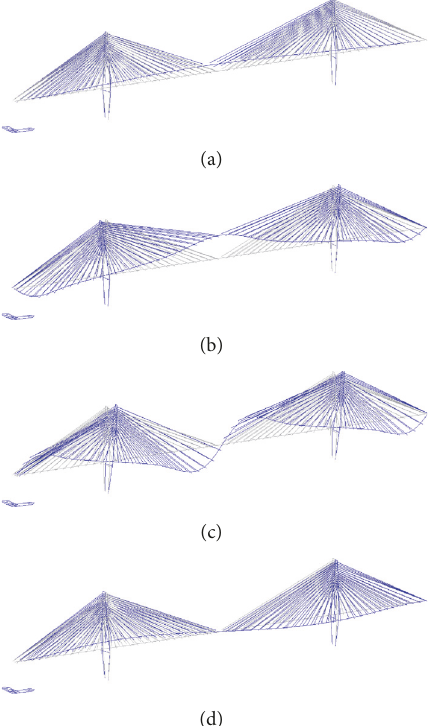
Figure 16: Mode shapes of the Skytrain Bridge: (a) 1st mode shape (lateral), (b) 2nd mode shape (vertical), (c) 3rd mode shape (vertical), and (d) 4th mode shape (lateral).